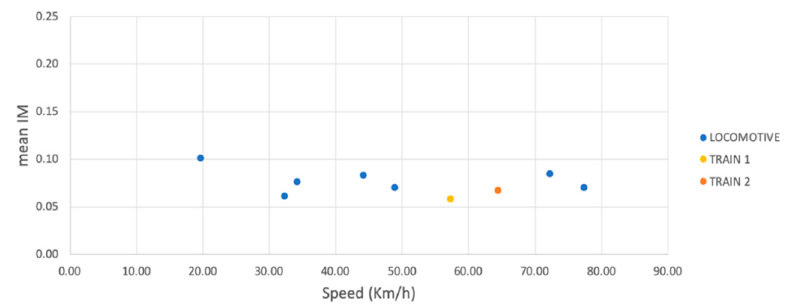
Figure 14. IM calculated, averaging the values of the five points on the span for each speed.